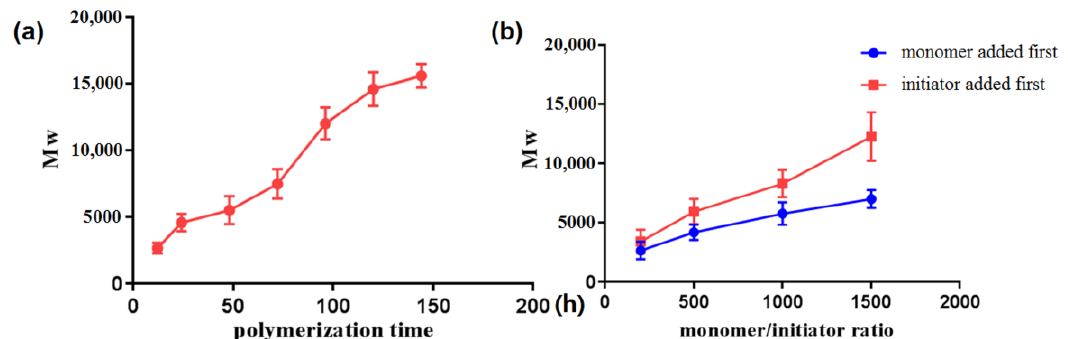
Figure 3. The influence of the polymerization time ( a ), monomer/initiator ratio, and the added sequence of initiator and monomer ( b ) during the polymerization process on the molecular weight.